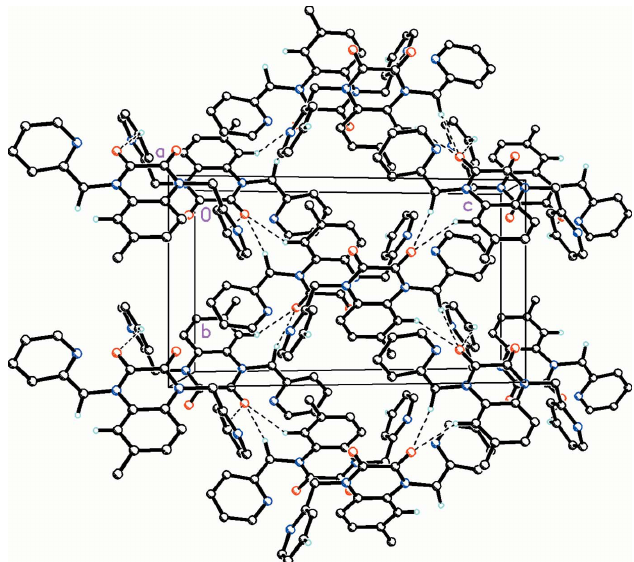
Figure 2 Packing diagram of the title compound viewed along the a axis. Dashed lines indicate weak C—H (cid:3)(cid:3)(cid:3) O interactions linking the molecules into a three-dimensional-network structure. H atoms not involved in these weak intermolecular interactions are omitted for clarity.